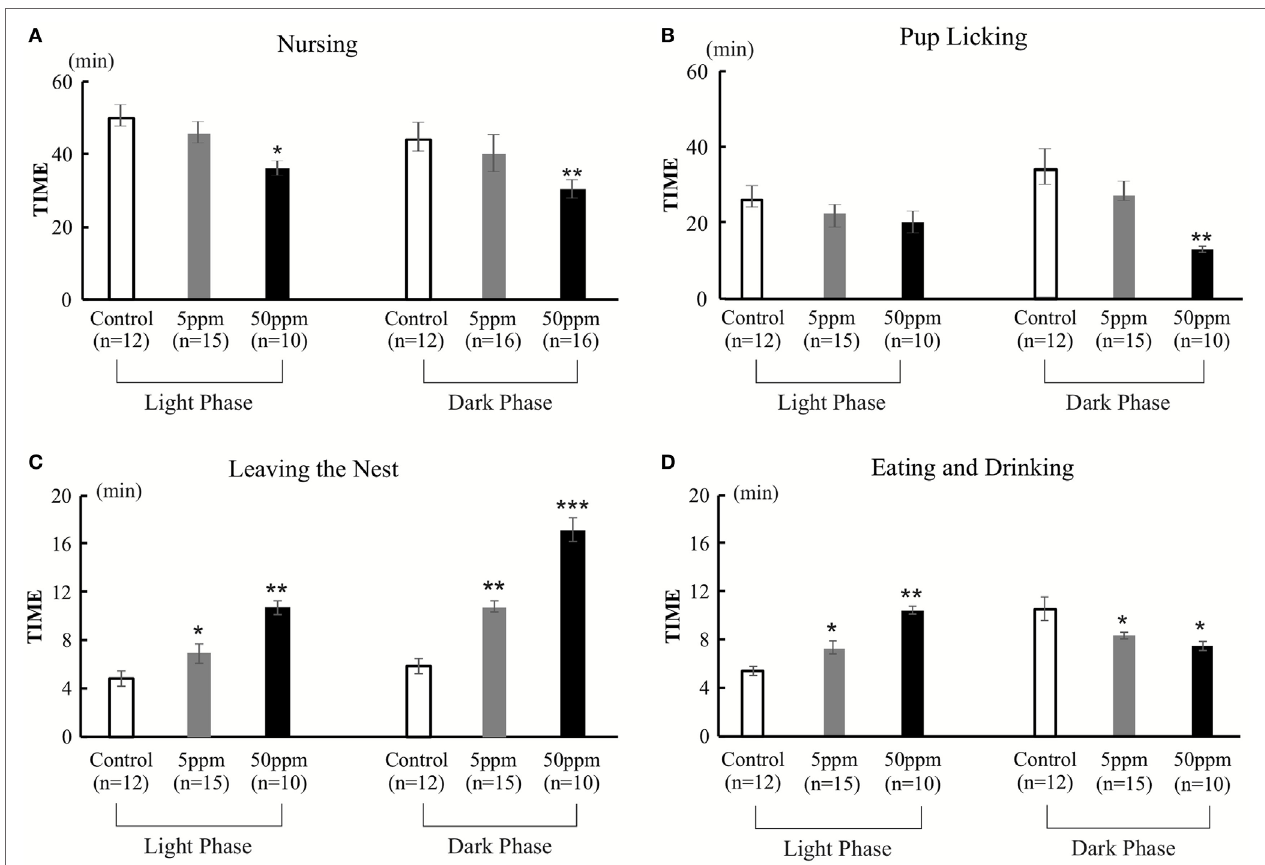
FigUre 6 | The duration of nursing, pup licking, leaving the nest, and eating and drinking in 1 h. Behavior was observed for two 1-h periods per day (light phase, 9:00–10:00; dark phase, 1:00–2:00). (a) Duration of nursing. Mice in the 50 ppm group spent less time nursing, both in light and dark phases. (B) Duration of pup licking. Mice in the 50 ppm group spent less time licking their pups in the dark phase. (c) Leaving the nest. Hypothyroid-treated mice spent longer out of the nest both in the light and dark phases (D) Duration of eating and drinking. Hypothyroid-treated mice spent more time eating and drinking in the light phase and less time in the dark phase. Data are the mean ± SEM, * p < 0.05; ** p < 0.01; *** p < 0.001 compared with the control group by Bonferroni